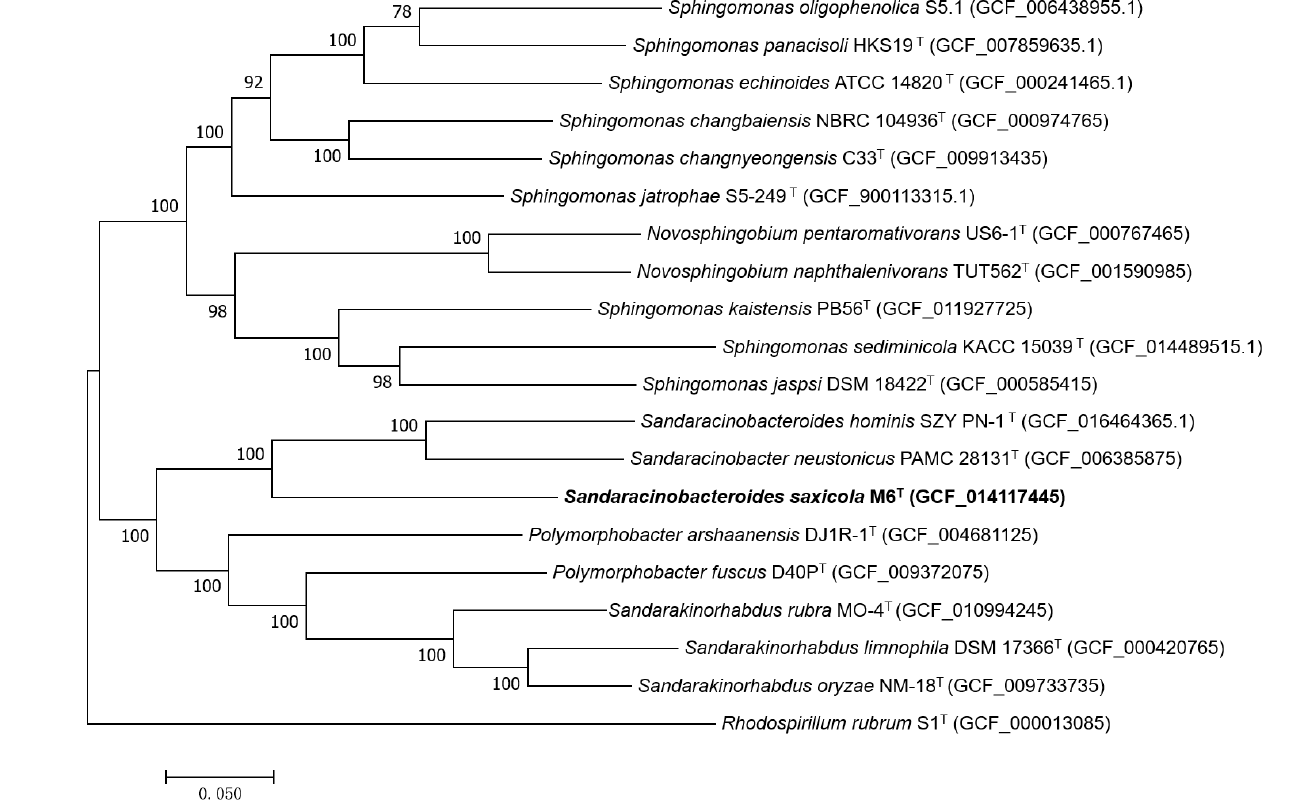
Figure 2. Maximum-likelihood phylogenetic tree based on the core genome indicating the phyloge- netic positions of strains M6 T with the related species. The scale bar indicates 0.020 substitutions per nucleotide position. Rhodospirillum rubrum S1 T (GCF_000013085) was used as an out group. GenBank accession numbers are listed for each sequence in parentheses.